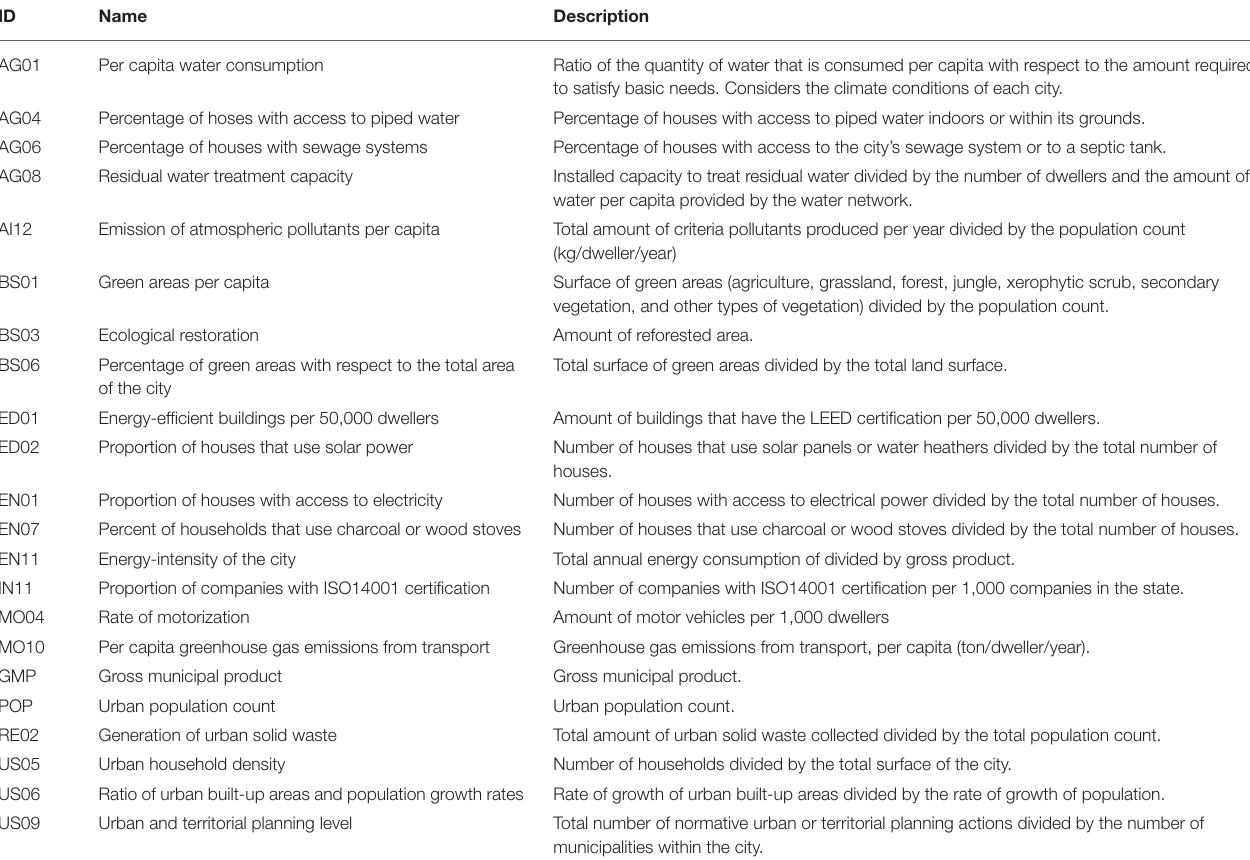
TABLE 1 | List of variables selected from PKSC for this study and their